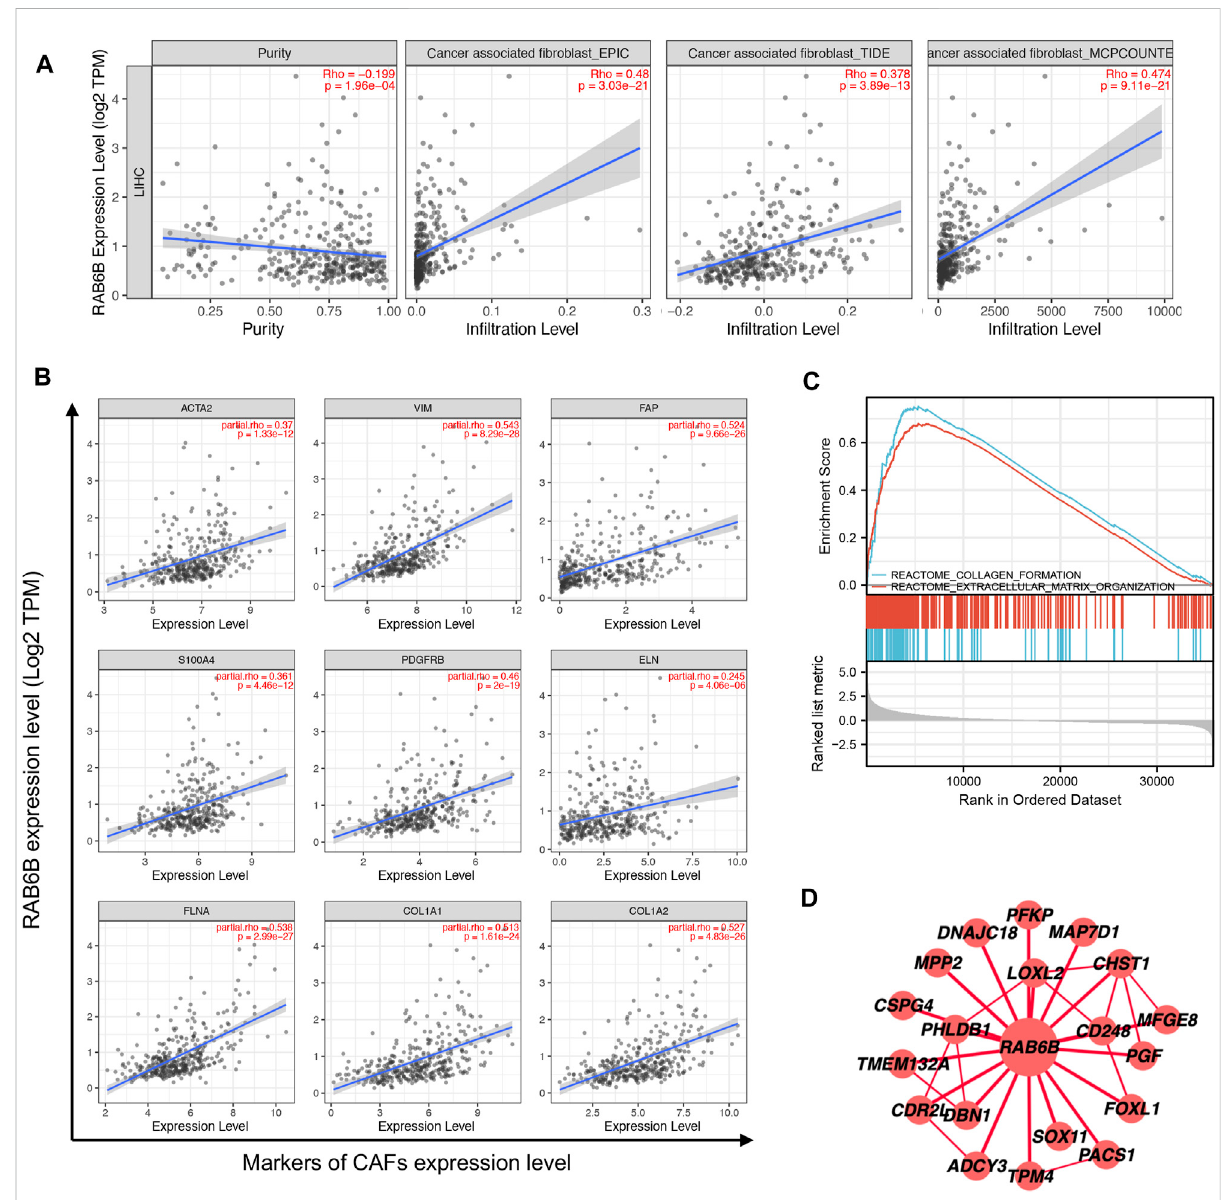
FIGURE 7 Correlation between the in fi ltration of CAFs and RAB6B expression in HCC. (A) RAB6B expression was positively correlated with the in fi ltration of CAFs in HCC based on the TIMER2.0 database. (B) RAB6B expression was positively associated with the main markers of CAFs, including ACTA2, VIM, FAP, S100A4, and PDGFRB, and was positively correlated with the expression of collagen-related proteins, including ELN, FLNA, COL1A1, and COL1A2. CAFs, cancer-associated fi broblasts. (C) The enrichment results of GSEA showed that upregulated RAB6B was positively correlated with “ collagen formation ” and “ extracellular matrix organization. ” (D) The RAB6B PPI network was performed from the HCCDB database. PPI, protein-protein